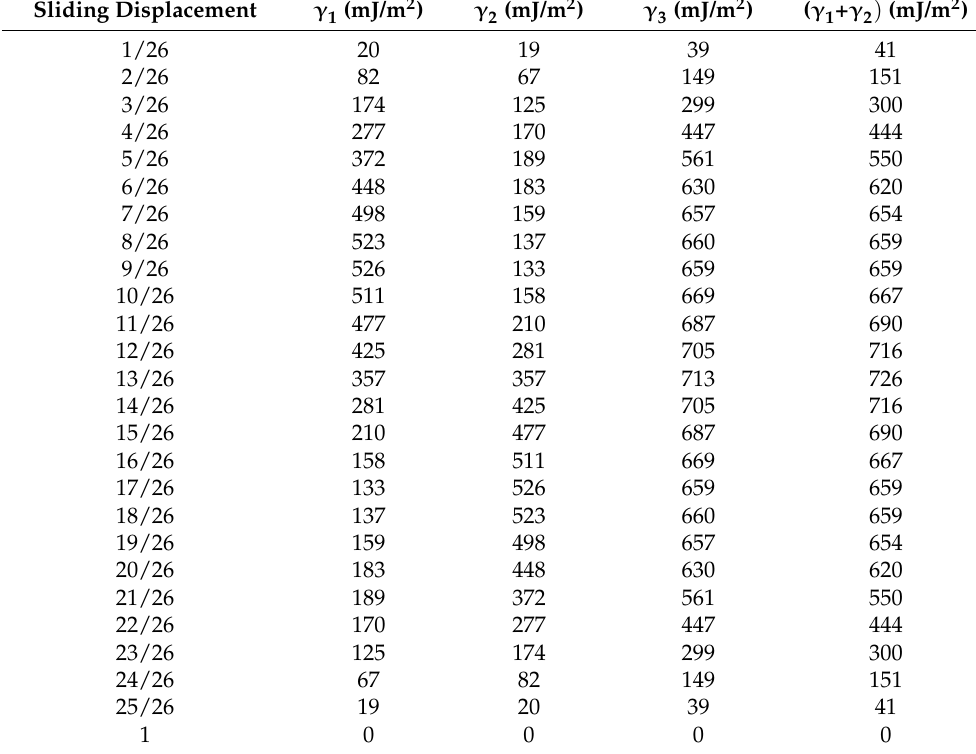
Table 2. The composite value of the two generalized stacking fault energies ( γ γ γ 1 , 2 in Figure 3 of fcc Al. √ (3a 0 / 6 ) is set to 1, where a 0 is the lattice constant, and the unit is Å. Sliding Displacement γ 1 (mJ/m 2 ) γ 2 (mJ/m 2